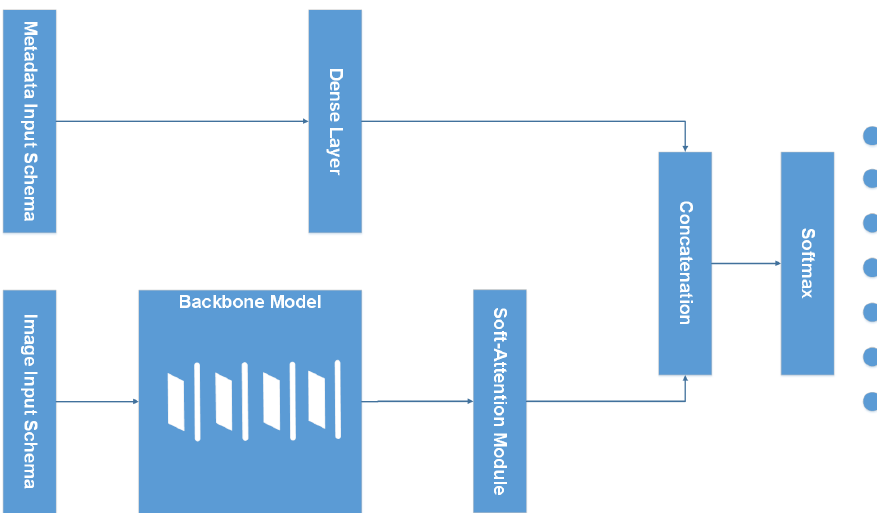
Figure 2. Overall model architecture.